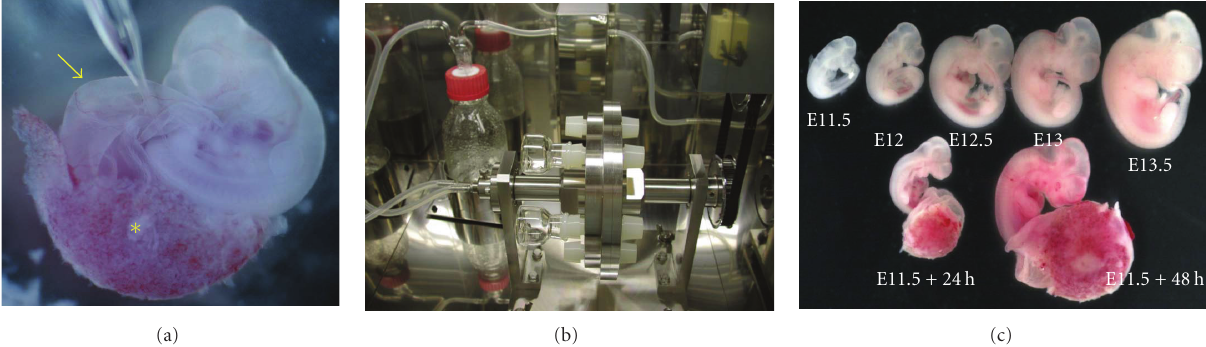
Figure 1: Strategy for nephron regeneration. MSCs were injected at the site of sprouting of the ureteric bud of E11.5 rat embryo (a). These embryos were developed in the whole-embryo culture system (b) for 48 hours. Embryos developed in this system shows the continuation of development in this system ((c): arrow, yolk sac; asterisk, placenta).